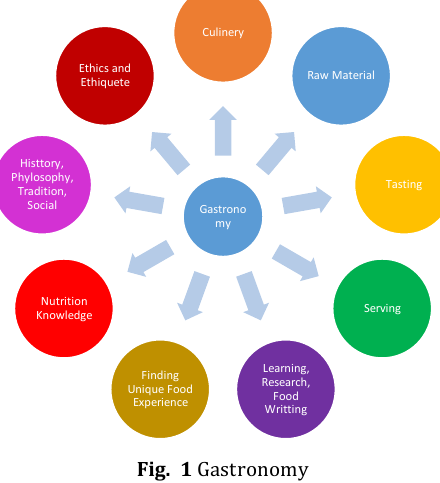
Source: Turgarini (2018) processed from Shenoy (2005), Manolis (2010), Santich (1996), Pullphothong & Sopha (2013), (Soeroso,